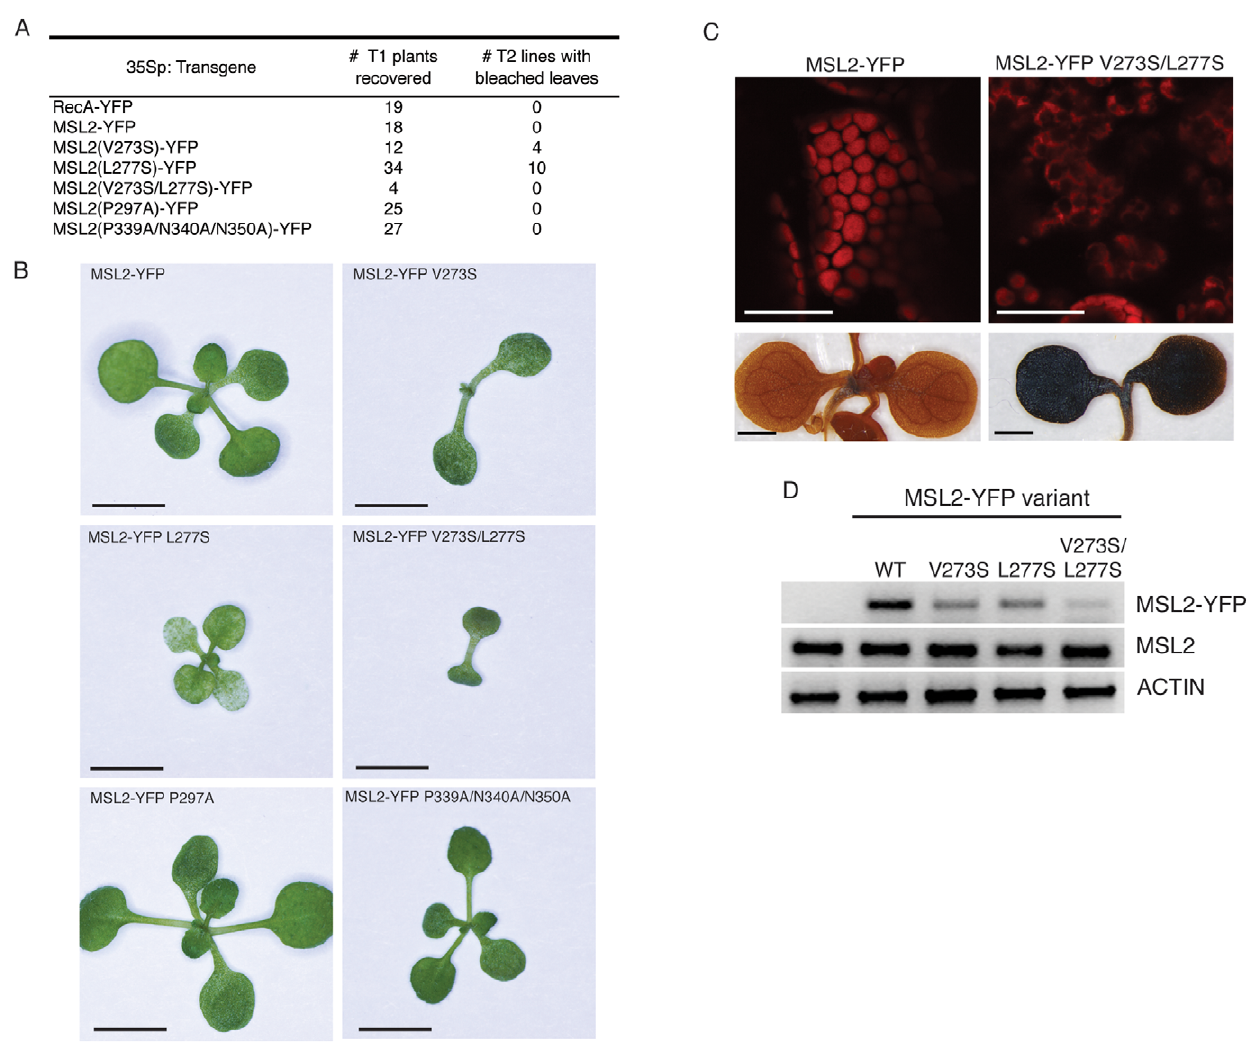
Figure 4. Mis-expression of MSL2-YFP V273S, L277S or V273S/L277S causes severe defects in leaf growth and chloroplast integrity. (A) Number of T1 plants recovered from side-by-side plant transformations and phenotypes of subsequent T2 lines. (B) Representative images of 2 week-old T2 seedlings. Size bar is 4 mm. (C) Top, representative confocal scanning images of cotyledons of the indicated T2 seedlings. Chlorophyll autofluorescence is pseudocolored red. Size bar is 30 microns. Bottom, representative T2 seedlings stained with Lugol’s reagent to indicate starch content. Scale bar is 1 mm. Note the loss of all leaf primordial, as frequently observed in these lines. (D) Agarose gel of PCR products specific to the transgenes and genes indicated to the right. cDNA derived from the indicated T2 lines shown in (D) was used as